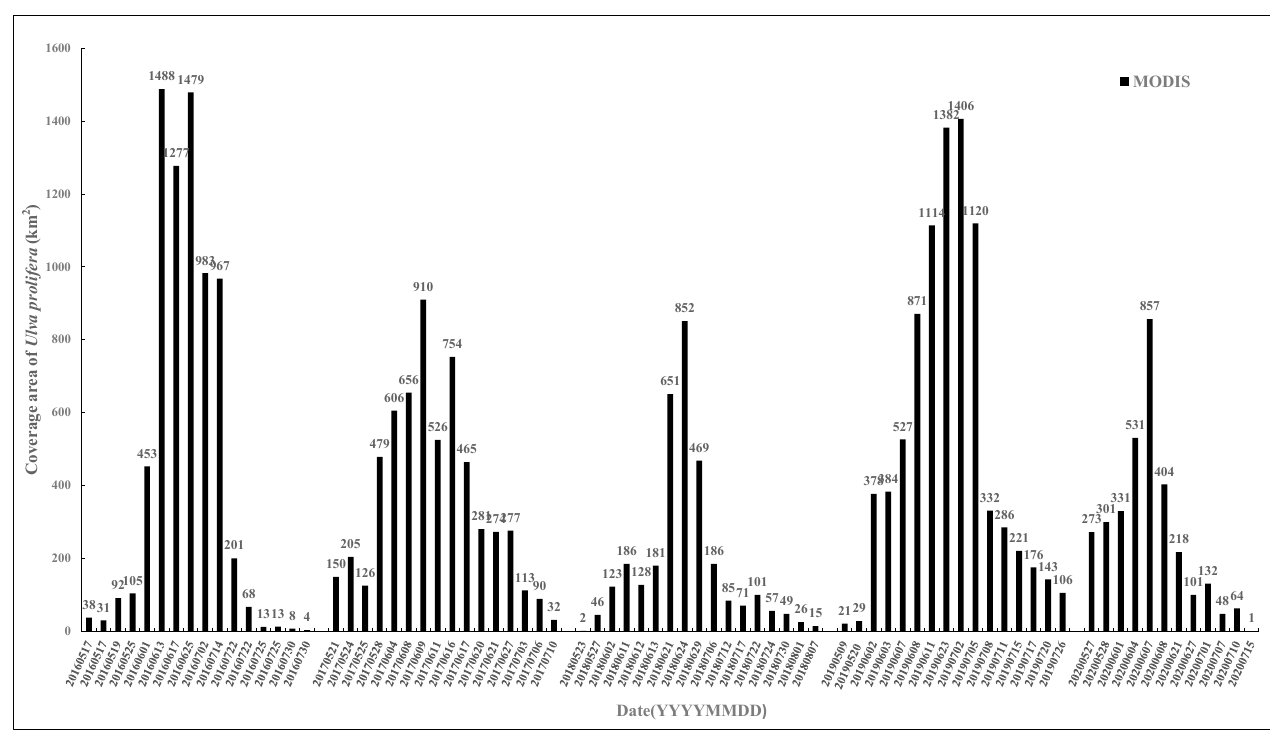
Figure 12. Statistical chart of U. prolifera area based on MODIS satellite in the study area from 2016 to 2020. Through the annual average statistics of the coverage area of U. prolifera in the five years (Figure 13), it was found that the area showed a decreasing trend year by year. And the results of MODIS were consistent with those of Landsat8/OLI and Sentinel-2/MSI. In general, the interannual coverage of U. prolifera in 2017, 2018, and 2020 was relatively small, while that of 2016 and 2019 was relatively large. Among the Landsat8/OLI and Sentinel-2/MSI results, the annual average area of algae in 2016 was the largest (521 km 2 ); compared with 2017 and 2018, the annual mean coverage of algae in 2019 increased to about 326 km 2 .